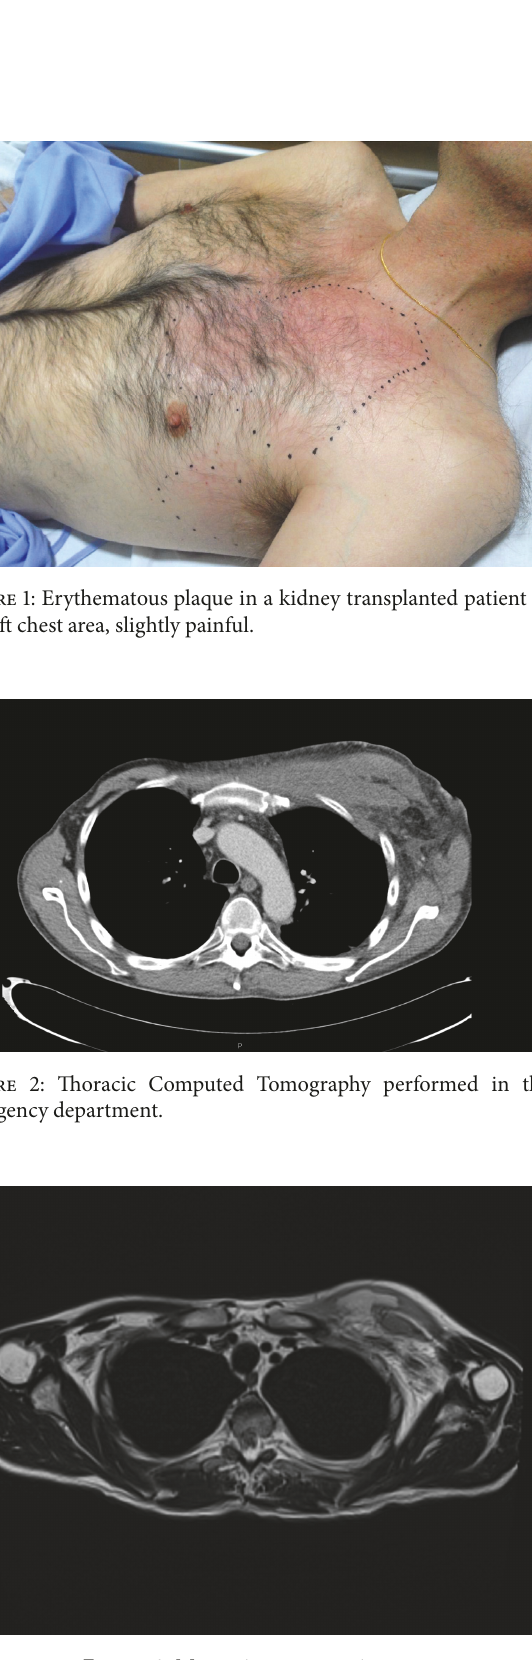
Figure 3: Magnetic resonance